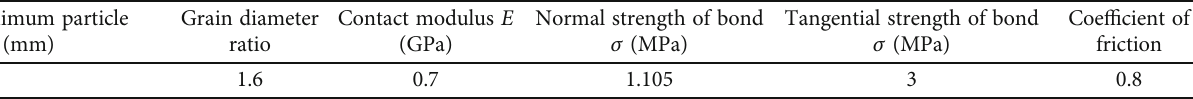
Table 1: Mesomechanical parameters of coal-rock specimens.